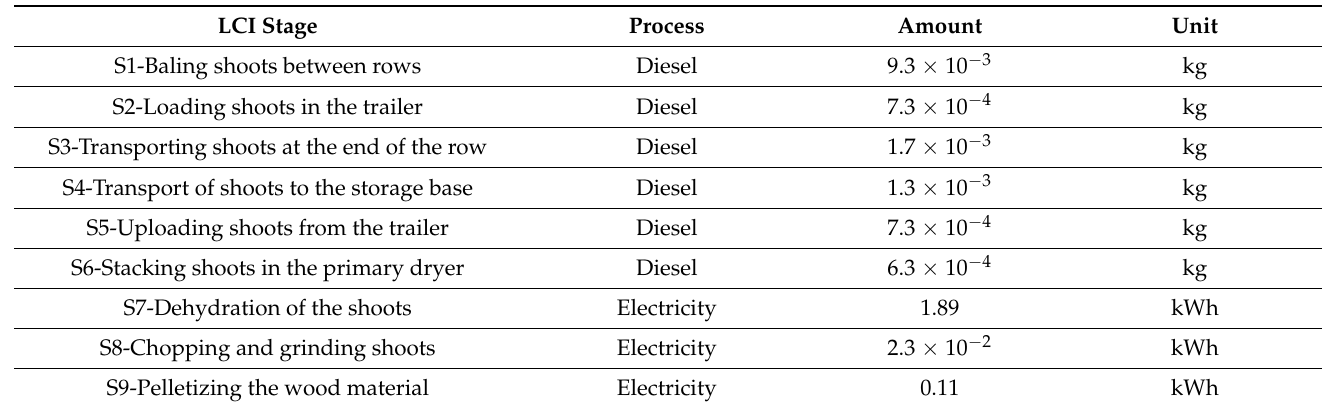
Table 2. Life cycle inventory for pellets/briquettes production (1